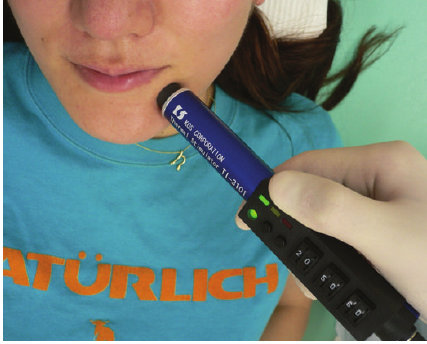
Figure 9: Nerve testing for hot or cold sensation.